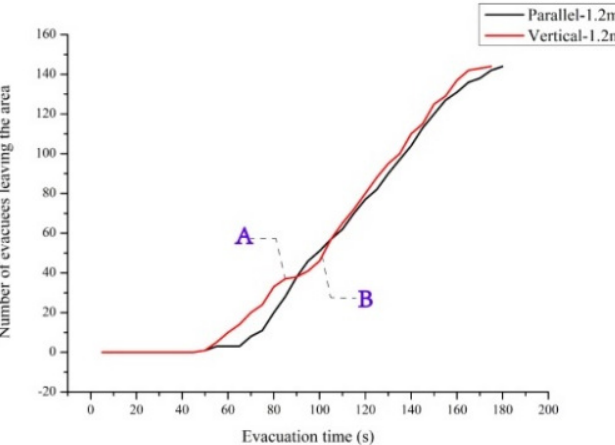
Figure 10. Evacuation time under different schemes.